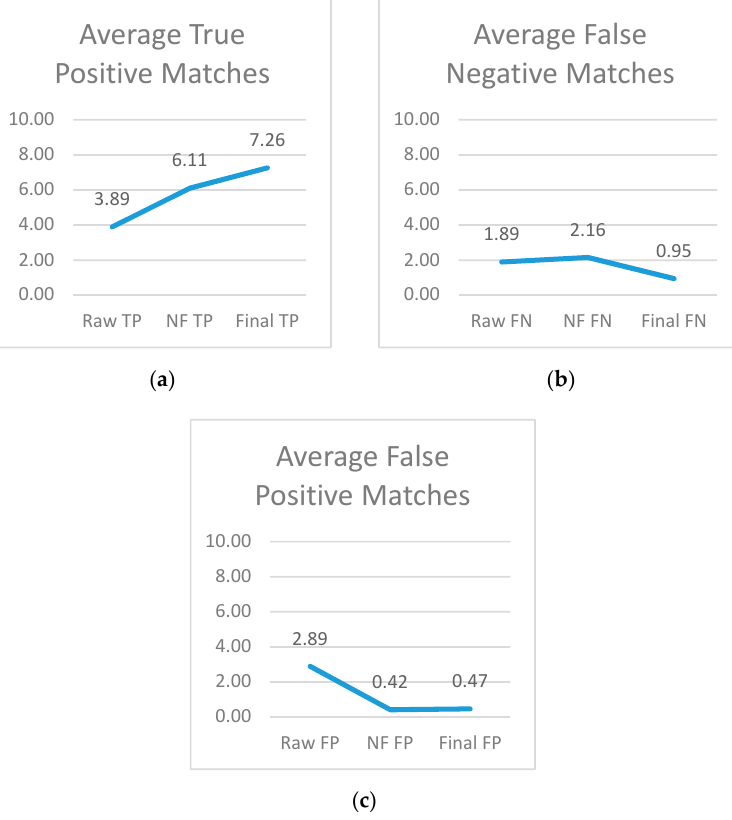
Figure 10. ( a ) The average true positive matches at each measuring point in the system, ( b ) the average of false negative matches at each measuring point in the system, and ( c ) the average of false positive matches at each measuring point in the system.